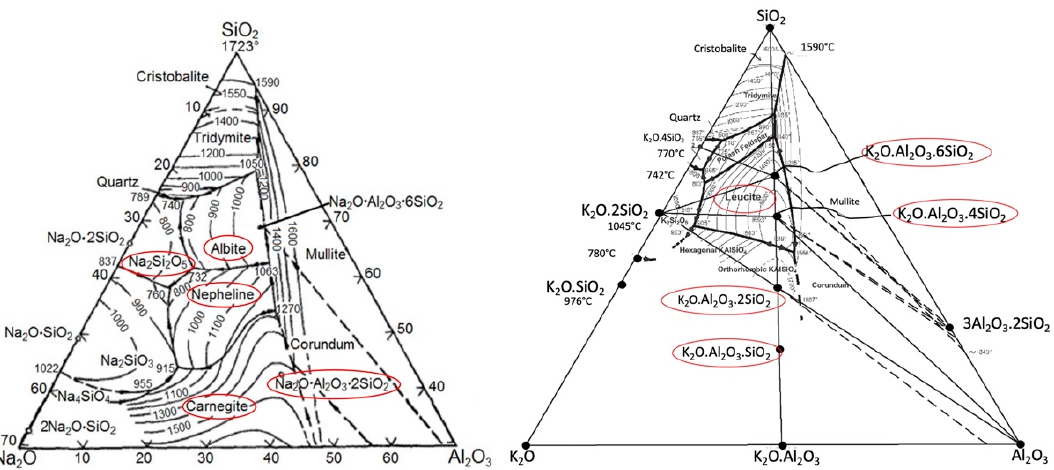
Figure 3. Ternary diagram of Na 2 O-SiO 2 -Al 2 O 3 [13] and K 2 O-Al 2 O 3 -SiO 2 [14], marking the individual phases formed during alkaline corrosion.